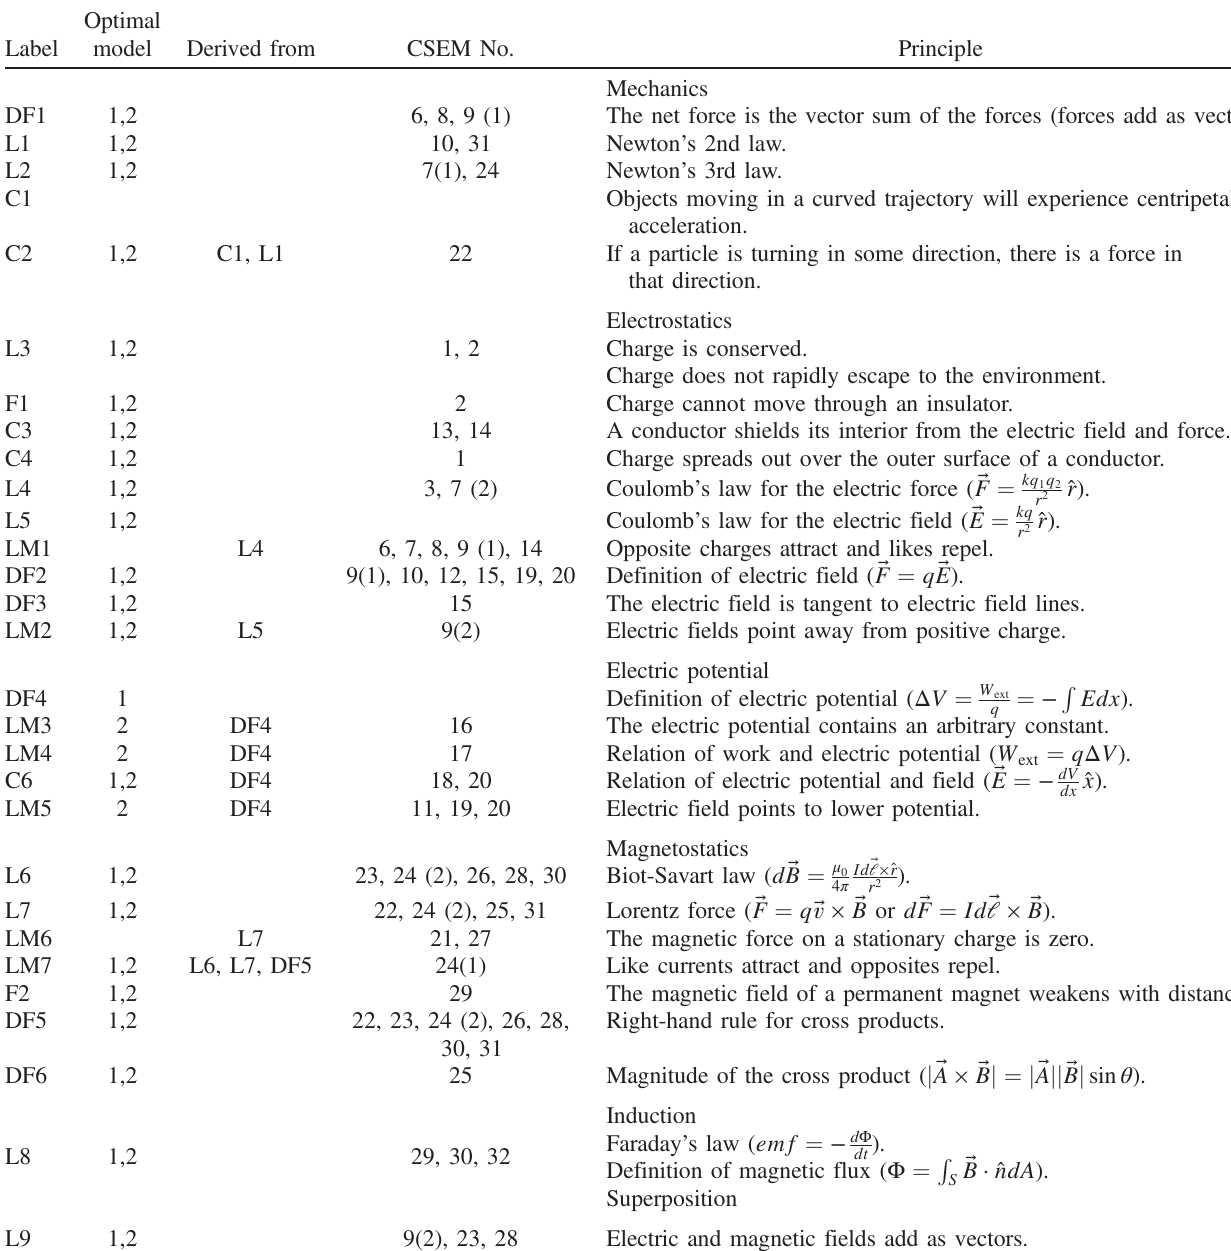
TABLE I. Theoretical model of electricity and magnetism as tested by the CSEM. The optimal model column indicates the samples for which the principle was included in the optimal model; M1-6 for sample 1 and M2-6 for sample 2. For items with two possible solution paths, the item number is followed by parentheses which enclose the solution path number.